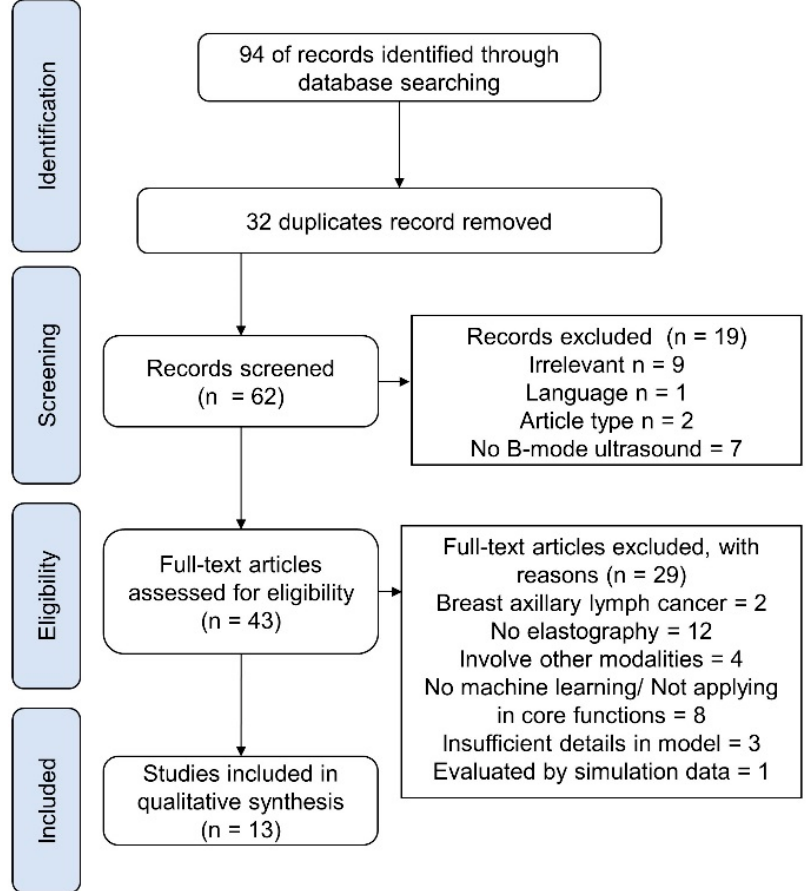
Figure 1. PRISMA flowchart of systematic search and selection process.